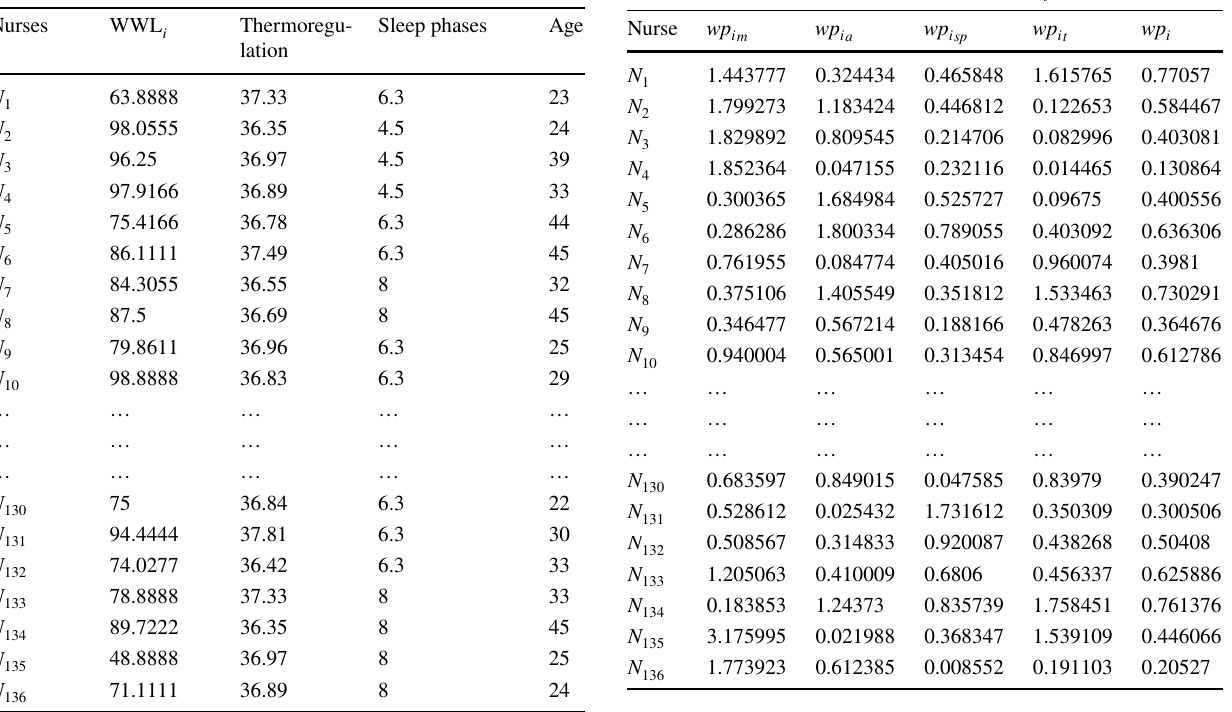
Table 5 Input matrix ( x ij ) for PCA Table 6 Weighted integrated effects matrix X